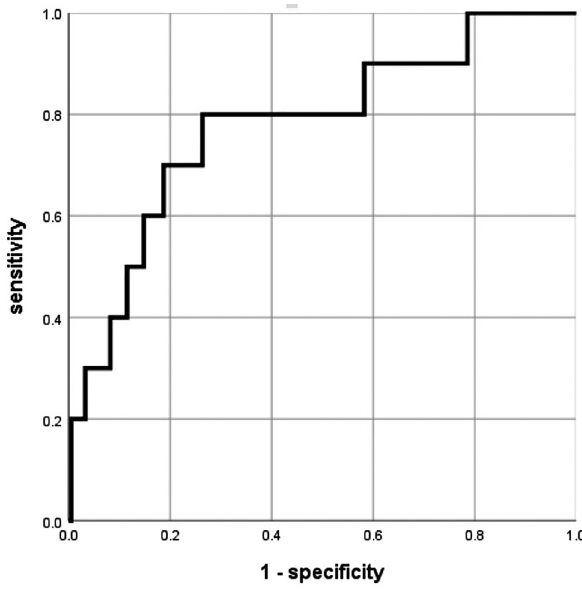
Figure 1: The cutoff values of hs-TnI, CK-MB and MYO in the joint diag- nosis of MACE during perioperative period of CABG 4 – 6 h after